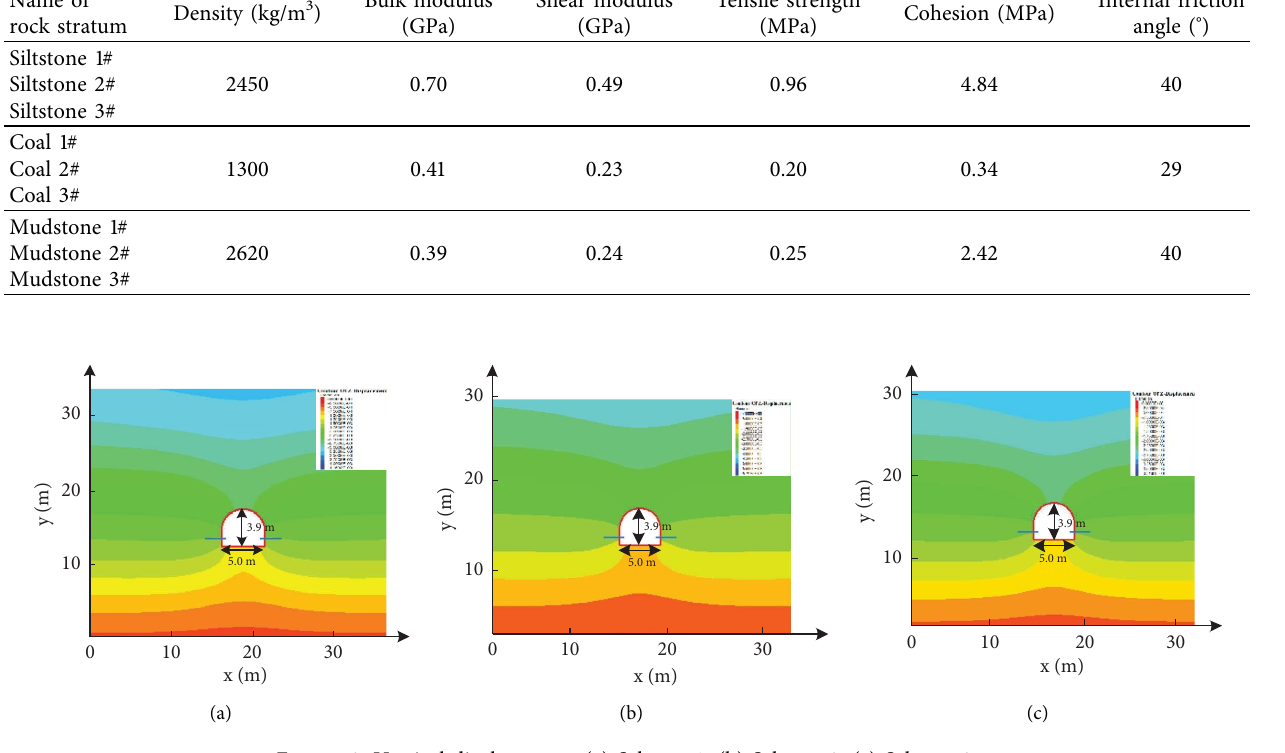
Figure 9: Vertical displacement. (a) Scheme 1. (b) Scheme 2. (c) Scheme 3.